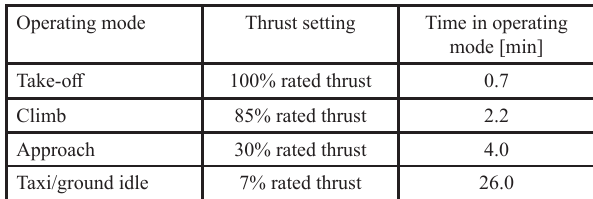
Fig. 1. ICAO reference LTO cycle [4] Table 1. LTO operating